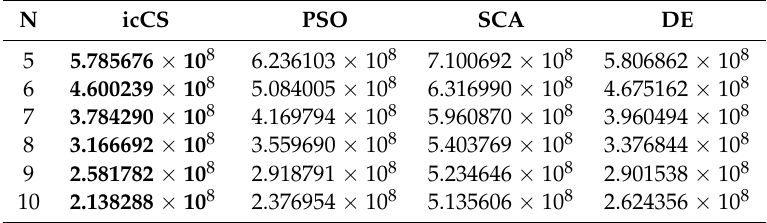
Table 7. The results of the algorithm proposed in this paper and other algorithms on the location of the drone logistics hub in Model 1.